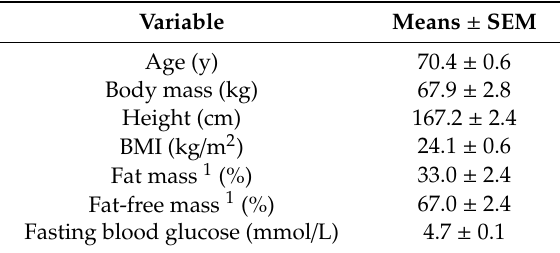
Table 2. Baseline